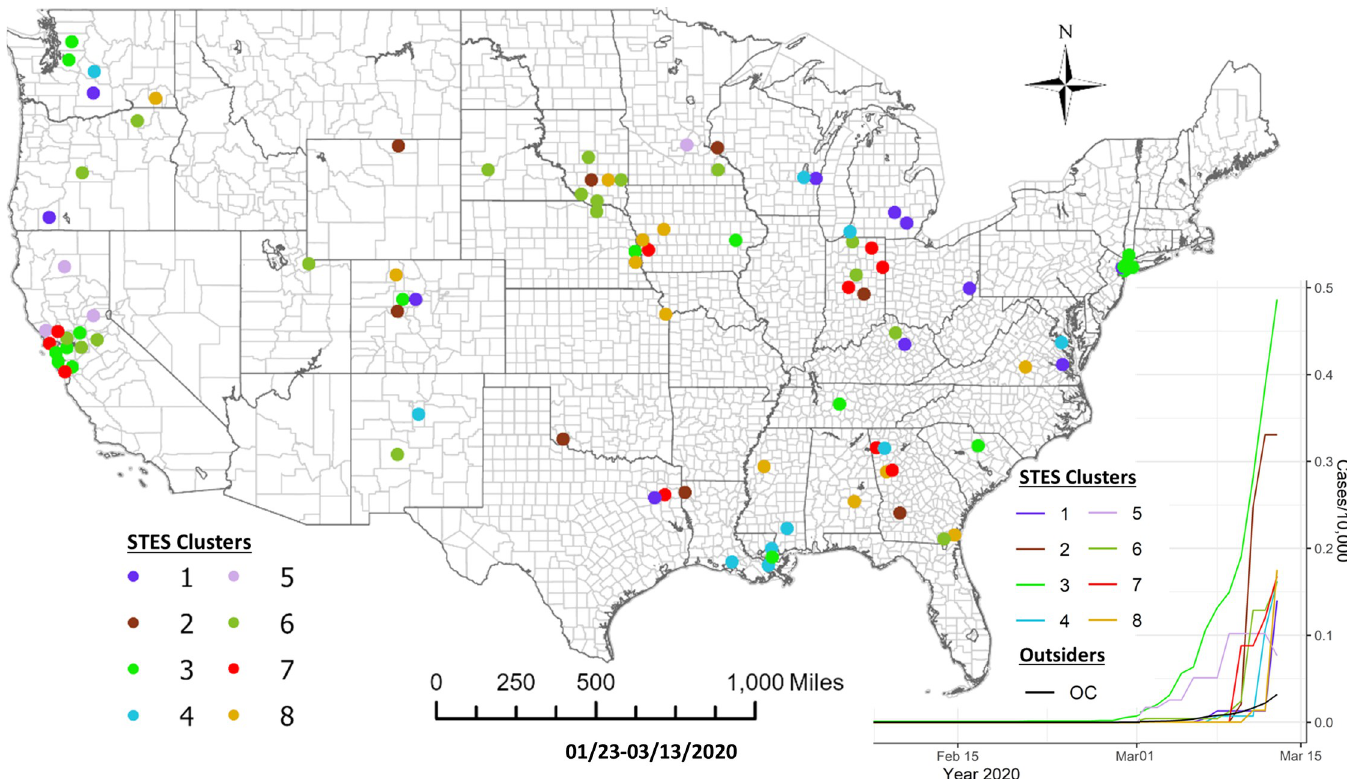
Fig 3. Sequence similarity-based COVID-19 clusters along with average temporal trends at the county level through 3/13/2020. This map includes the counties with higher relative risk (RR > 1) contained in all the clusters detected by scan statistics in Fig 1. The average temporal trends of cumulative cases for STES clusters 1–8 on the map appear at the bottom right. Notice that the colors of STES clusters match with correspondingly colored dots on the map and with the colors of the STES cluster curves on the graph. OC includes all counties not included in the clusters.